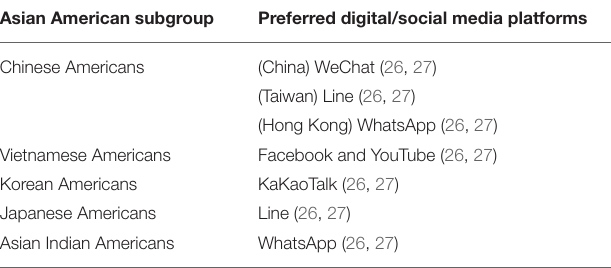
TABLE 1 | Preferred digital/social media platforms by Asian American